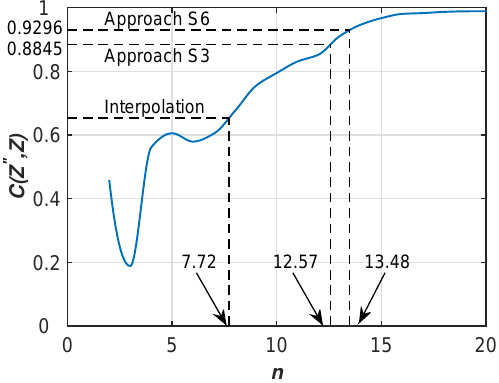
Figure 10. Correlation coefficients C ( Z (cid:48)(cid:48) , Z ) against different values of n .